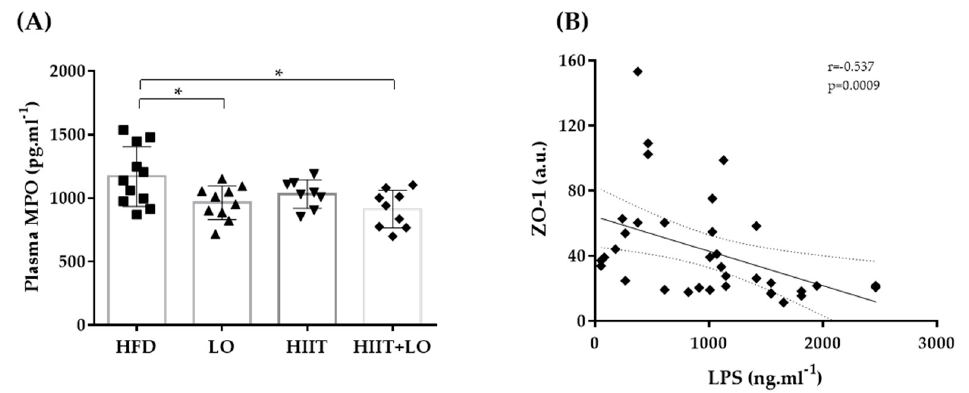
Figure 6. ( A ) Plasma myeloperoxidase (MPO) levels in the four groups and ( B ) correlation of lipopolysaccharide (LPS) and ZO-1: HFD ( n = 12), LO ( n = 11), HIIT ( n = 8), and HIIT + LO ( n = 9) at the end of phase 2 (training and/or LO supplementation for 12 weeks). * p < 0.05.